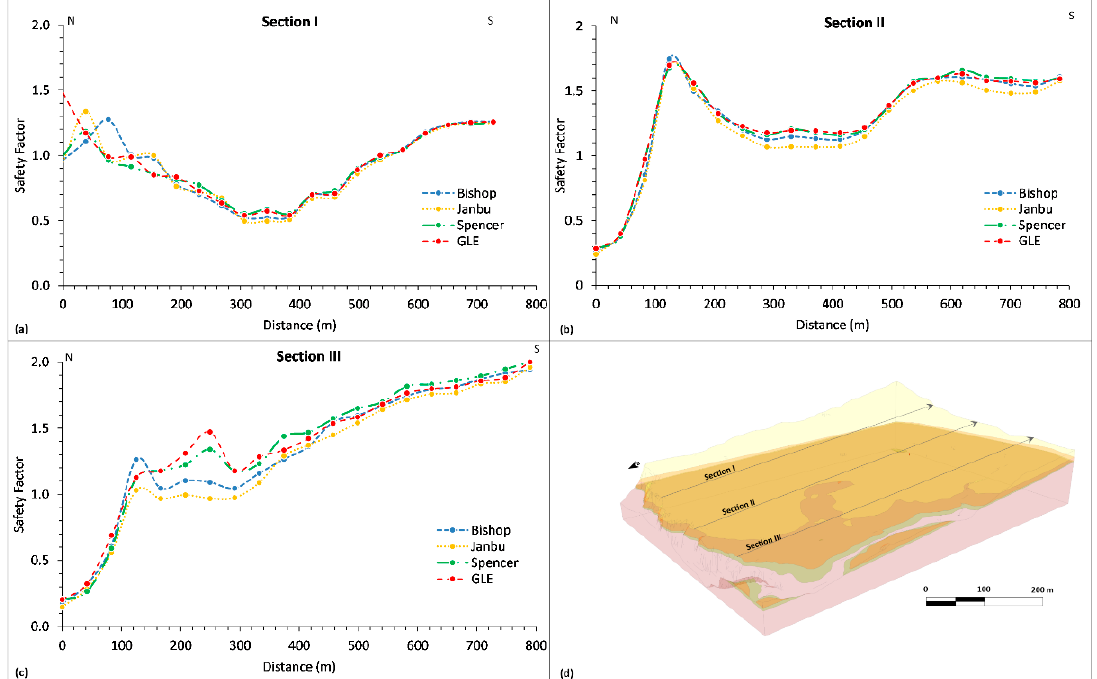
Figure 9. The factor of safety values of Sections I ( a ), II ( b ) and III ( c ) using two-dimensional limit equilibrium methods (Slide2 software). The analysis was performed using Bishop, Janbu, Spencer and GLE; ( d ) location of Sections I, II and III.